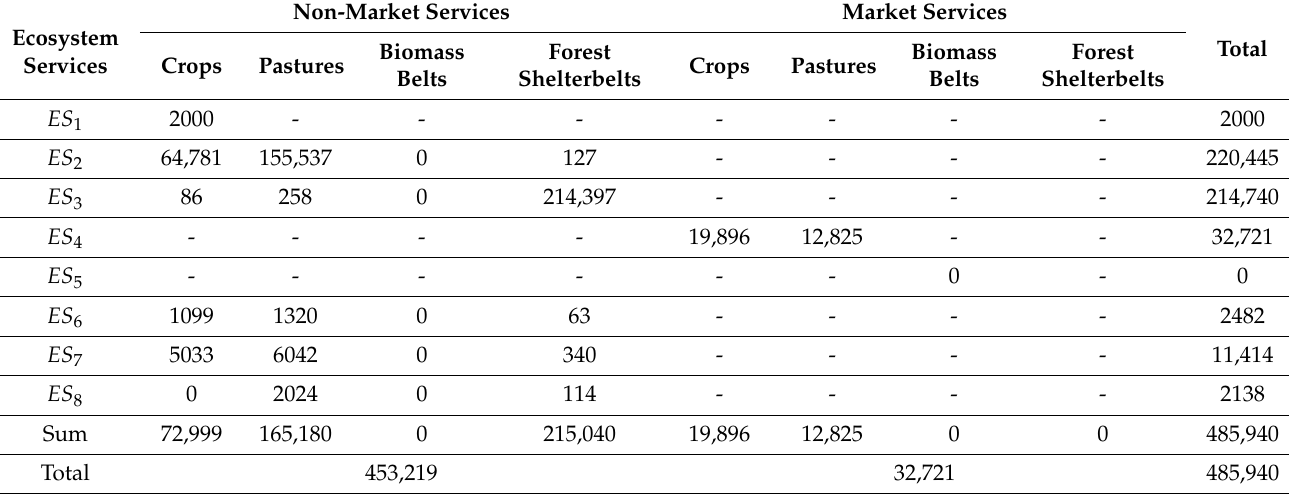
Table 4. Economic value of ecosystem services in land reclamation scenario, thousand UAH y − 1 .